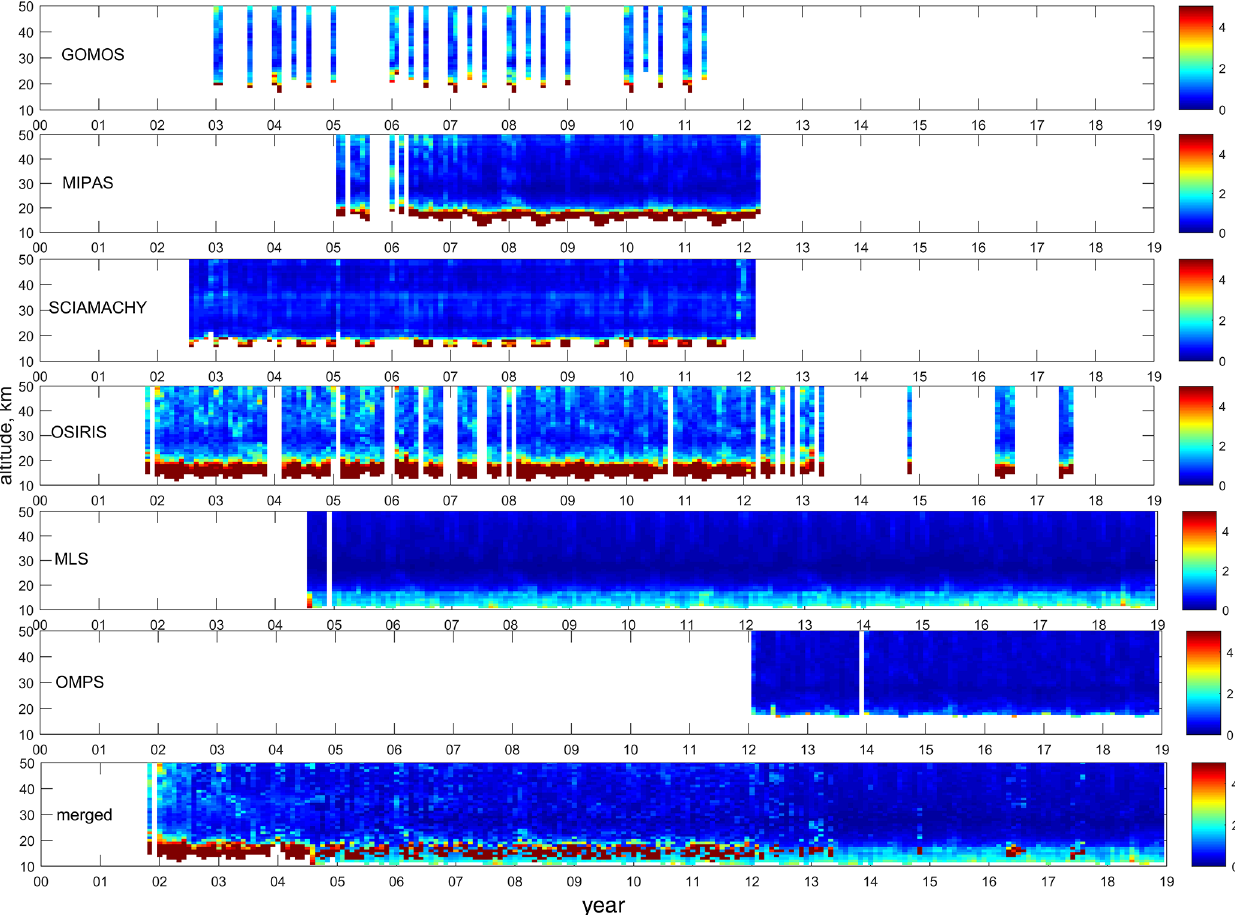
Figure 7. An example of uncertainties in deseasonalized anomalies (in %) for individual instruments and the merged dataset in the spatial bin 0–10 ◦ N, 0–20 ◦